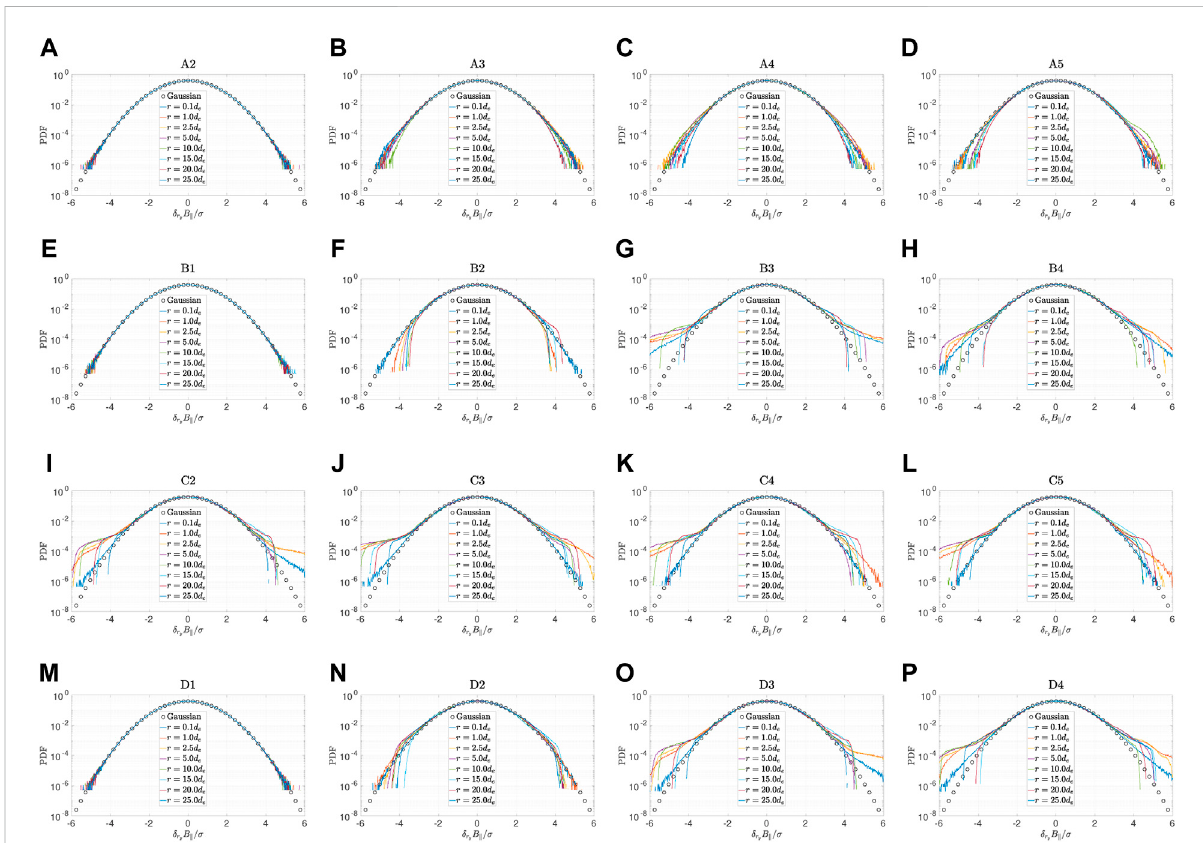
FIGURE 3 Comparison of the probability distribution function of δ B (cid:1) along Y axis at Ω e t ≈ 111.80. (A) – (D) : Run A2 to A5. (E) – (H) : Run B1 to B4. (I) – (L) : Run C2 to C5 (M) – (P) : Run D1 to